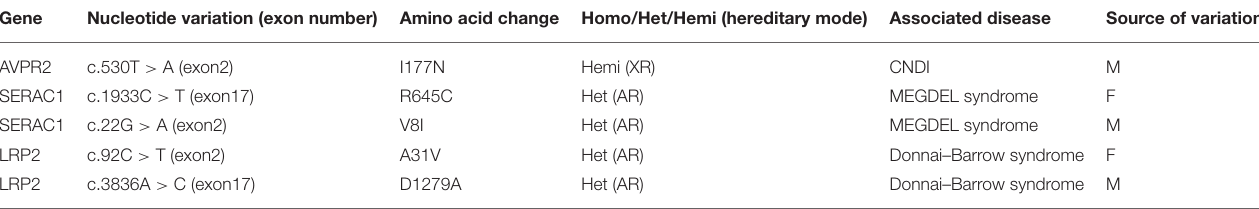
TABLE 2 | Mutations detected by Next Generation